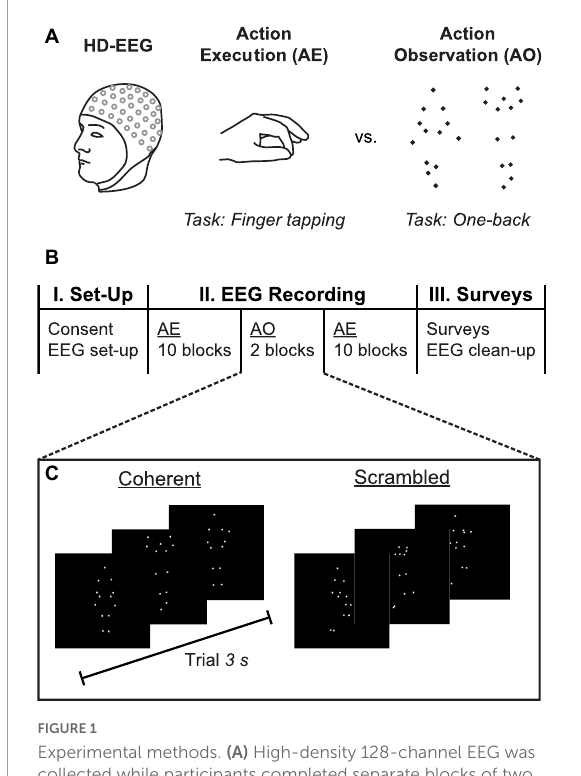
FIGURE1 Experimental methods. (A) High-density 128-channel EEG was collected while participants completed separate blocks of two different tasks: action execution (AE), in which the participant was instructed to alternate between resting and tapping the index and middle fingers of both hands against the respective thumbs; and, action observation (AO), in which the participant observed point-light display (PLD) animations of whole-body human movements while continuously monitoring for immediate repetitions (one-back task). (B) Timeline of experiment. Participants completed 10 blocks of AE, followed by two blocks of AO, and another 10 blocks of AE. Following the EEG recording, participants filled out surveys including the autism-spectrum quotient (AQ) questionnaire. (C) Sample trials from the AO task, which included one block each of Coherent biologically plausible PLDs and Scrambled stimuli in which the starting locations of the dots were randomly displaced. Each PLD animation had a duration of 3